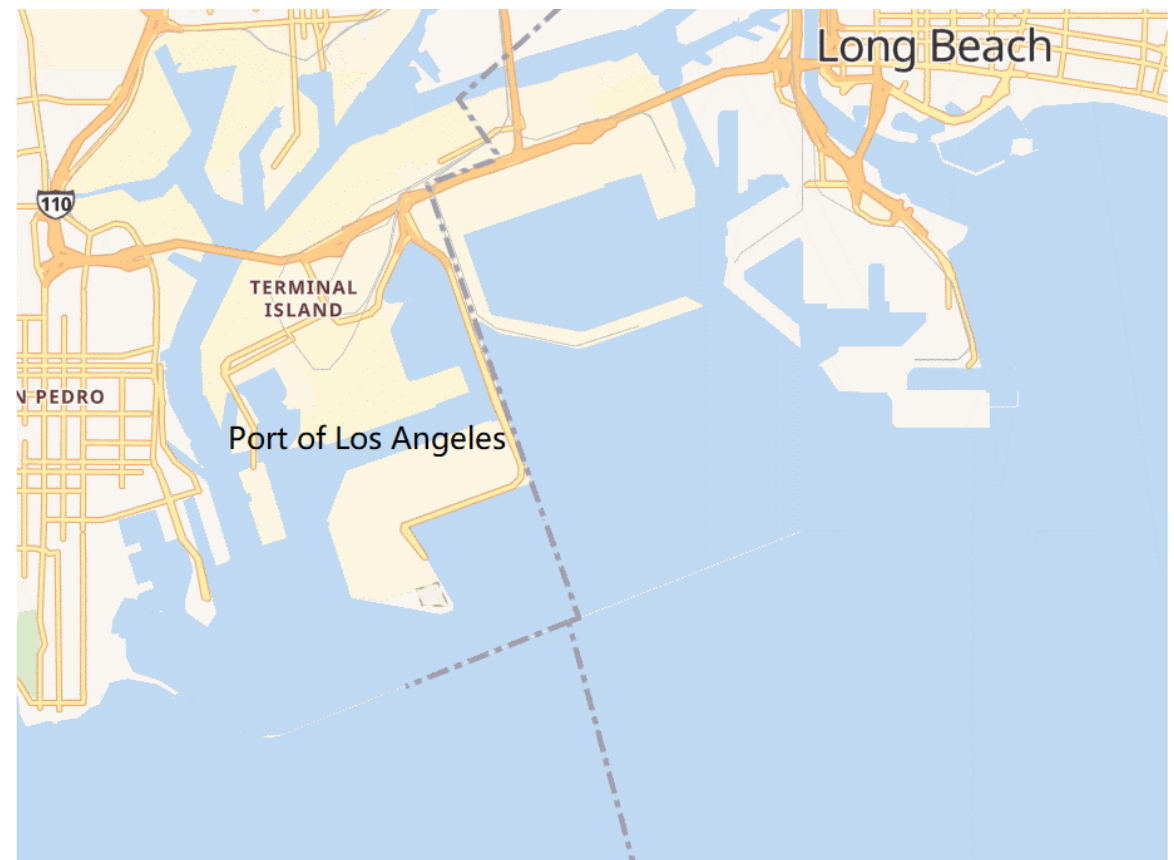
Figure 1. The ports of Los Angeles and Long Beach and related sea areas.